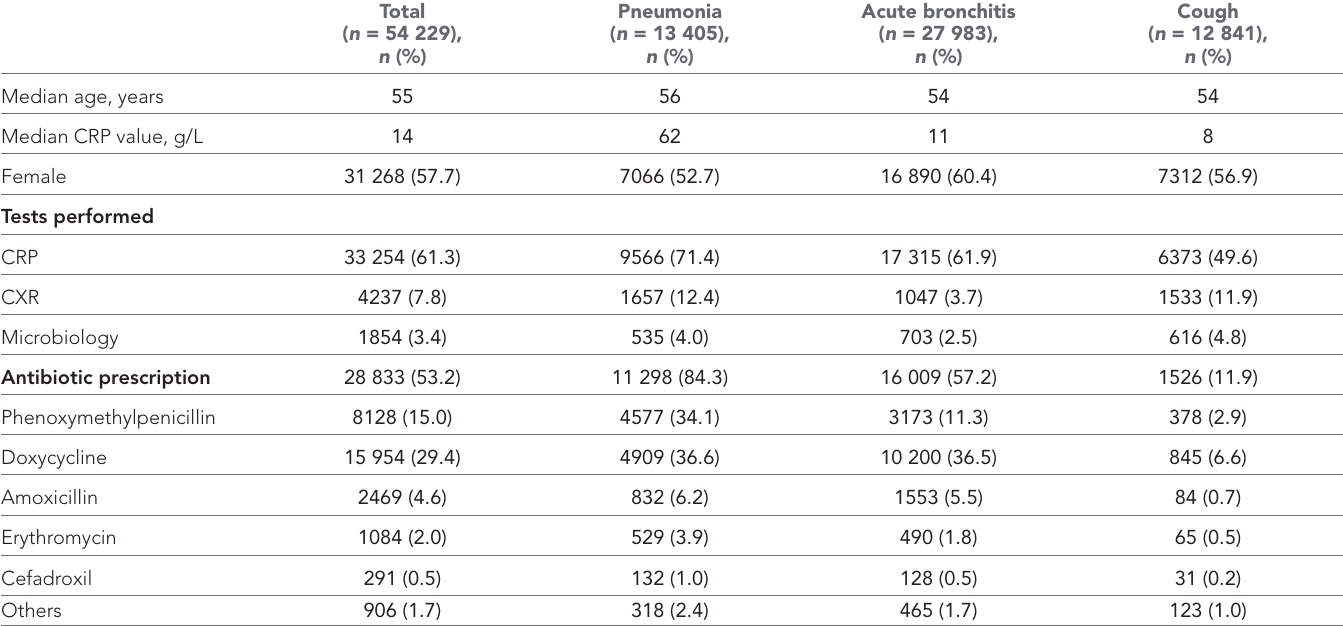
Table 1 Characteristics of patients aged 18–79 years with lower respiratory tract infections in primary care, distribution of diagnostic tests performed, and proportion of patients prescribed antibiotics for each diagnosis